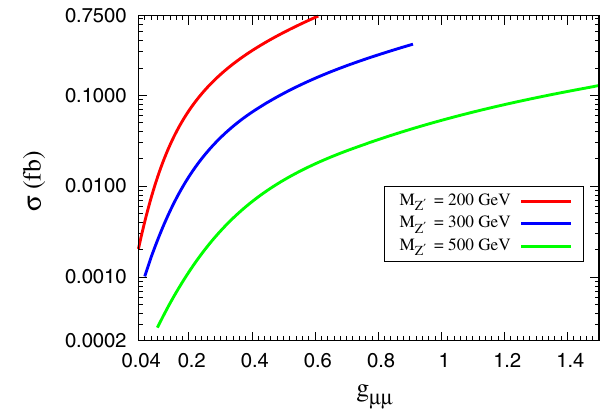
√ s = 14 TeV for 3 μ + (cid:3) E T channel as